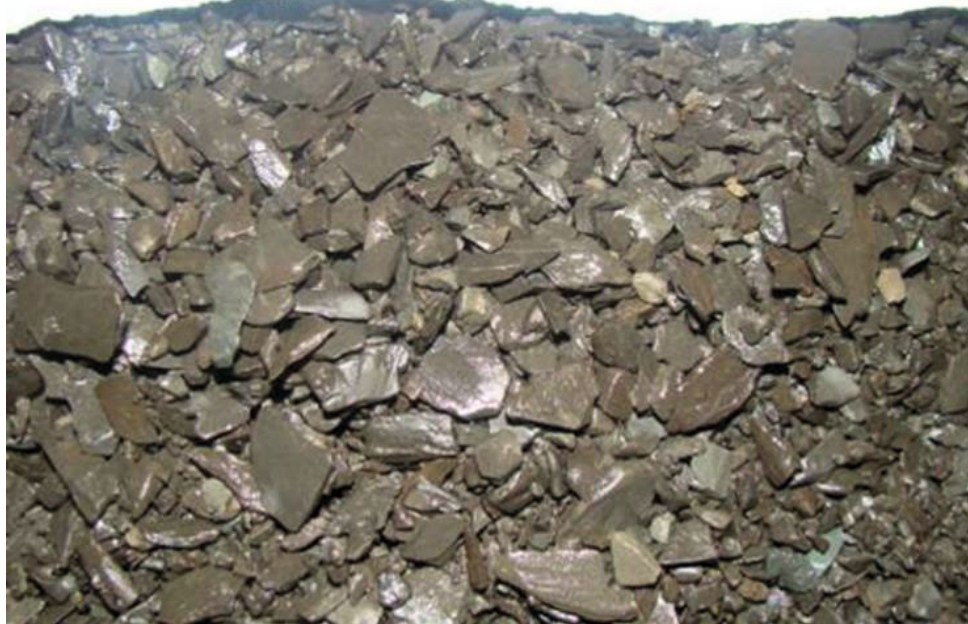
Figure 7: Debris from the middle-deep transition shale interval of Bohai oil fi eld of China.